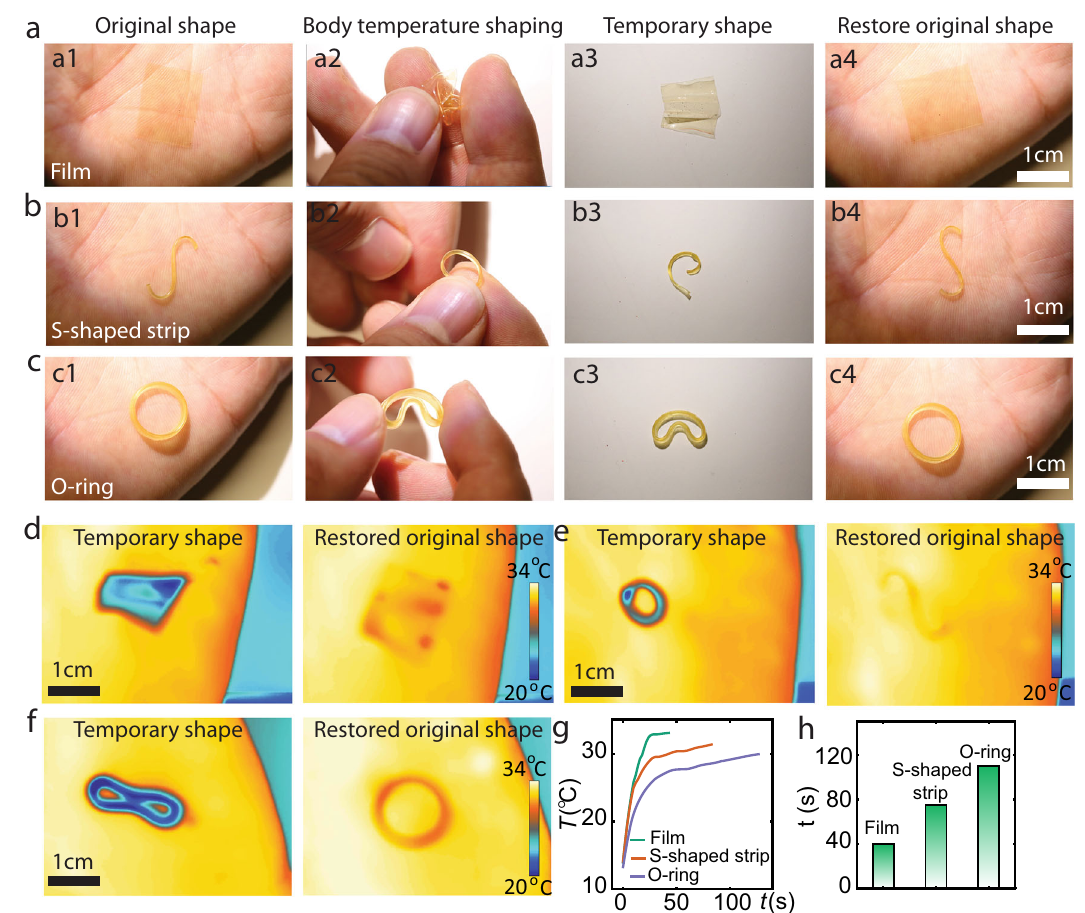
Fig. 5 | Body temperature triggered shape memory effect. Photographs of humanpalm-stimulustriggeredshapememoryprocessesof a fi lm, b S-shapestrip, and c theO-ring.a1 – a4representtheshapeandrecoveryprocessofthe fi lm.b1 – b4 represents the shape and recovery process of the S-shape strip and c1 – c4